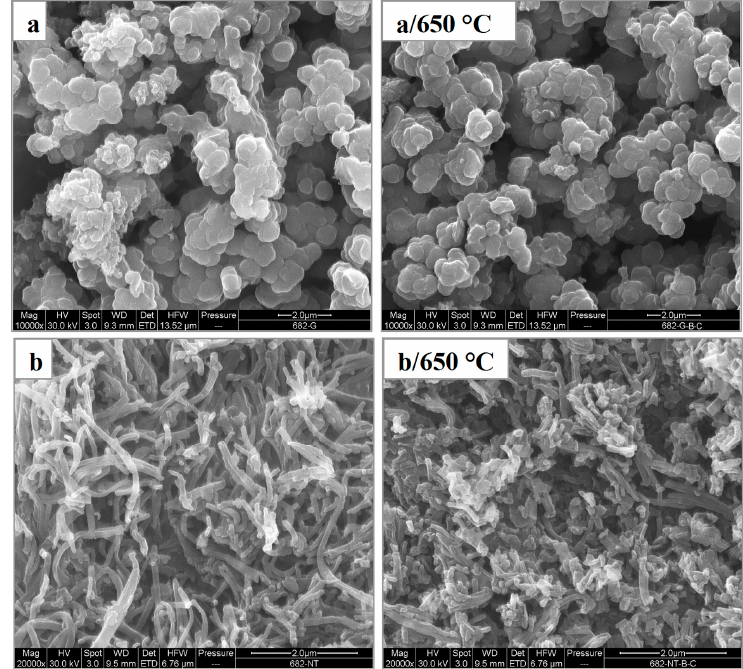
Figure 1. Scanning electron micrographs of ( a ) original globular polypyrrole and ( b ) polypyrrole nanotubes. They are depicted before- (left column) and after- carbonization at 650 °C (right column).